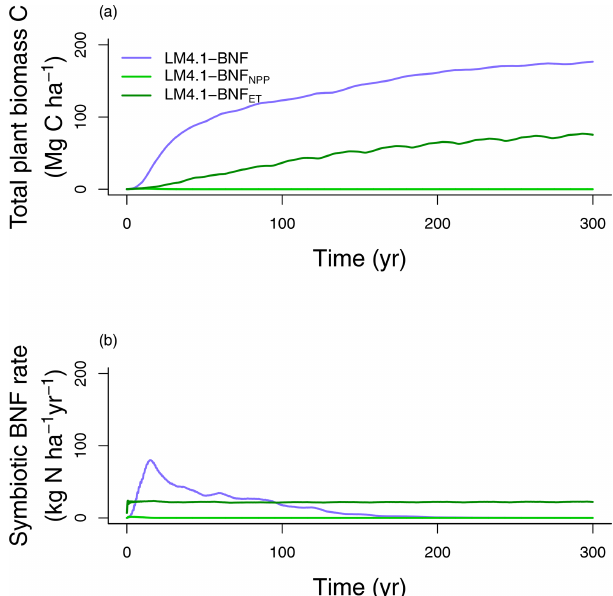
Figure 9. Simulated (a) total plant biomass C and (b) symbi- otic BNF rate over time from LM4.1-BNF, LM4.1-BNF NPP , and LM4.1-BNF ET